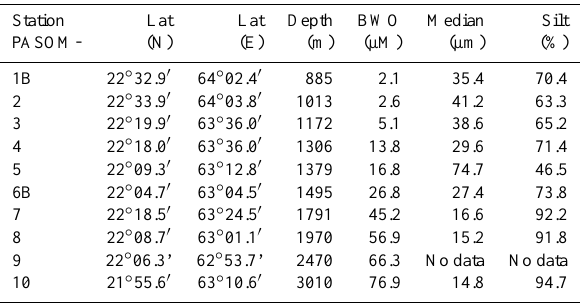
Table 1. Original station name, station positions, water depth, bottom-water oxygen (BWO) content, median grain size and silt content. In the text and figures stations are referred to according to their water depth.